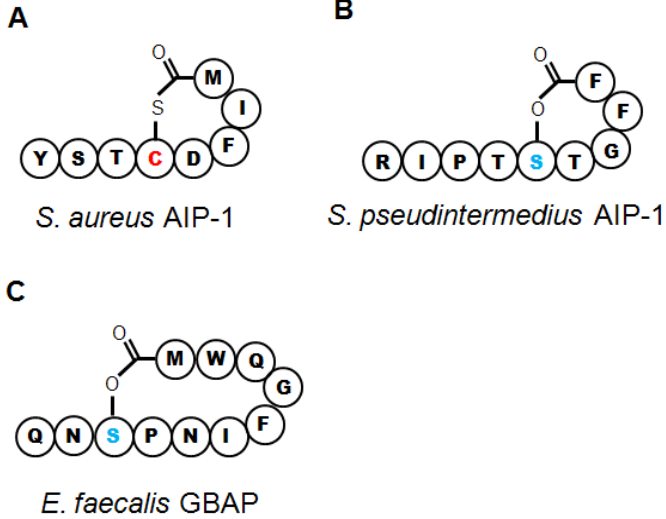
Figure 2. Structures of thiolactone and lactone signal peptides. ( a ) Structure of the prototypical autoinducing peptide, S. aureus AIP-1. ( b ) AIP-1 from S. pseudintermedius , the only reported Staphylococcus species with a lactone autoinducing molecule. ( c ) Gelatinase biosynthesis activating peptide (GBAP) from Enterococcus faecalis